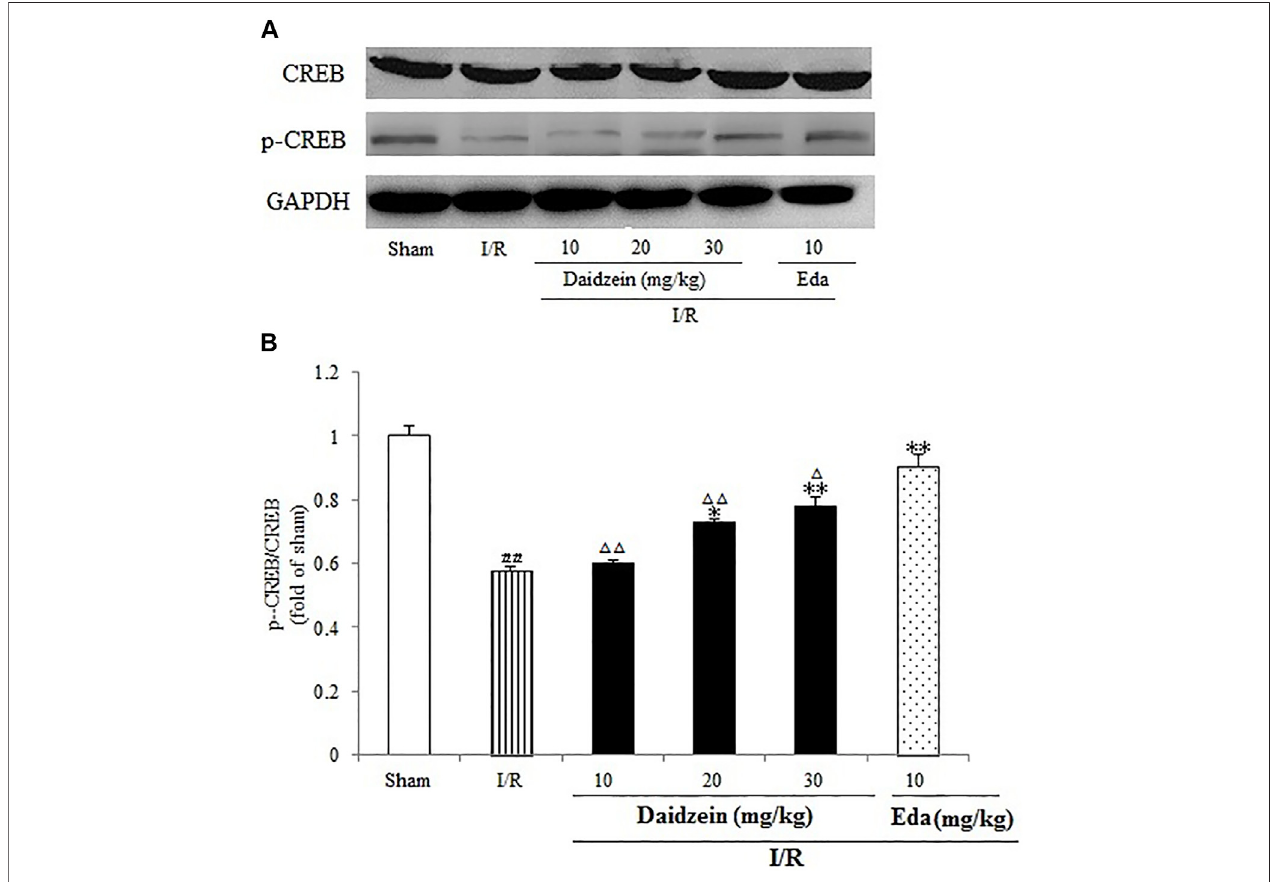
FIGURE 11 | Daidzein conducts the activation for BDNF/Akt/CREB signalling channel for providing neuro-repair in rats. (A) Representative protein bands of p-CREB and CREB. (B) p-CREB/CREB within the sham, I/R or daidzein-treatment rats ’ brain infarct region. Values are indicated as means ± standard errors of the means (SEMs; n (cid:2) 3). # p < 0.05, noticeably distinct from sham; * p < 0.05, noticeably distinct from I/R; △ p < 0.05, △△ p < 0.01, compared with the Eda group.